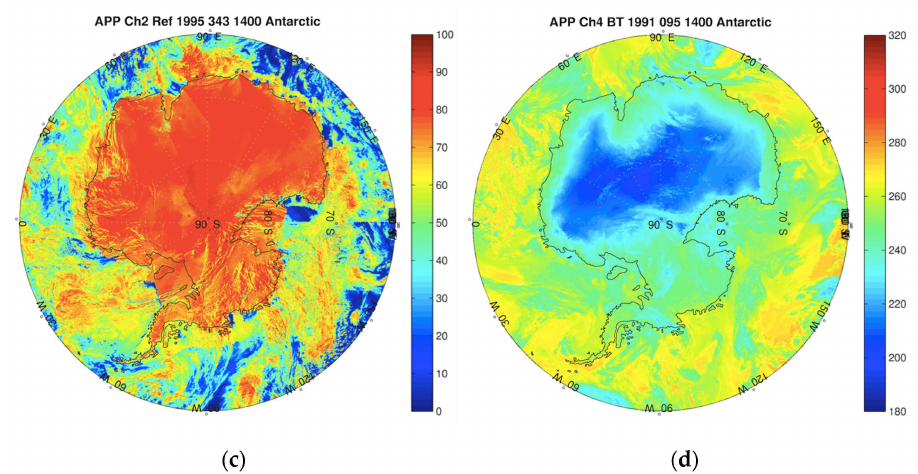
Figure 2. Top: APP channel 1 reflectance (%) over the Arctic on Julian day 91 of 1991 at 14:00 local solar time (LST) ( a ), and channel 4 brightness temperature (K) on day 95 of 1991 at 04:00 LST ( b ). Bottom: APP channel 2 reflectance over the Antarctic on day 343 of 1995 at 14:00 LST ( c ), and channel 4 brightness temperature on day 95 of 1991 at 14:00 LST ( d ).